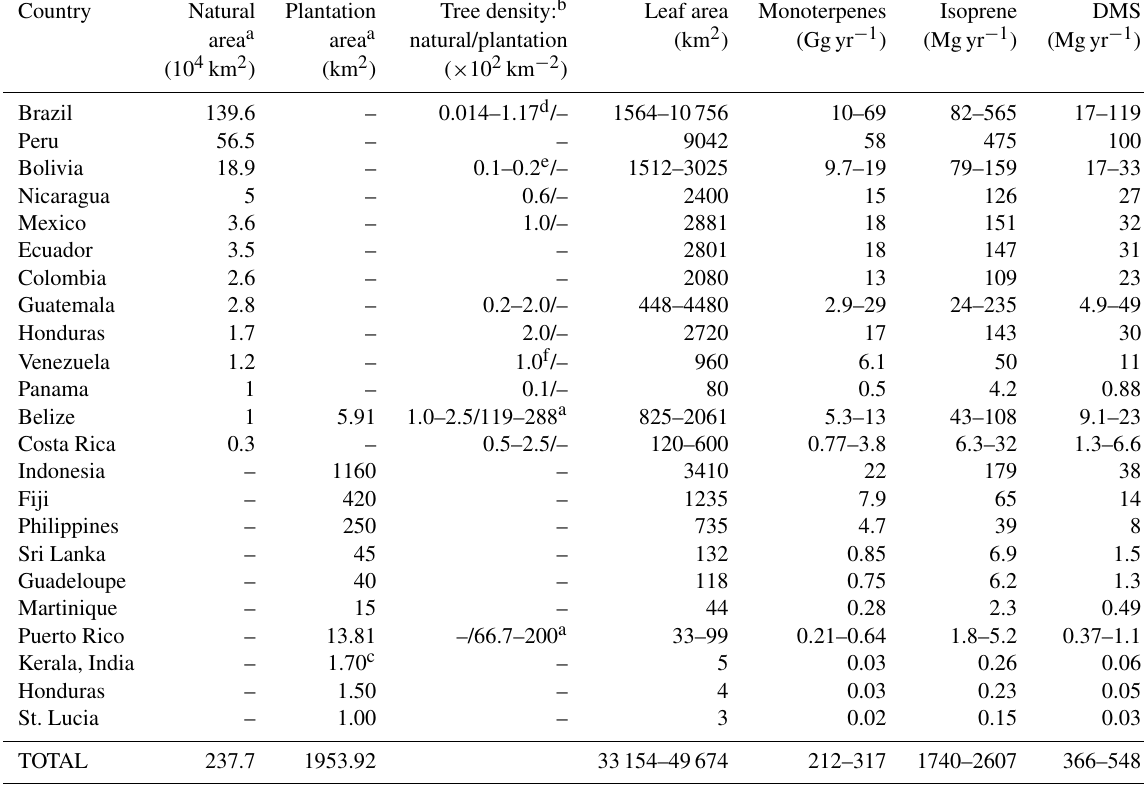
Table 4. Distribution of mahogany in natural forests and in plantations in terms of ground area, tree density, leaf area and calculated annual emission fluxes of monoterpenes, isoprene and DMS.